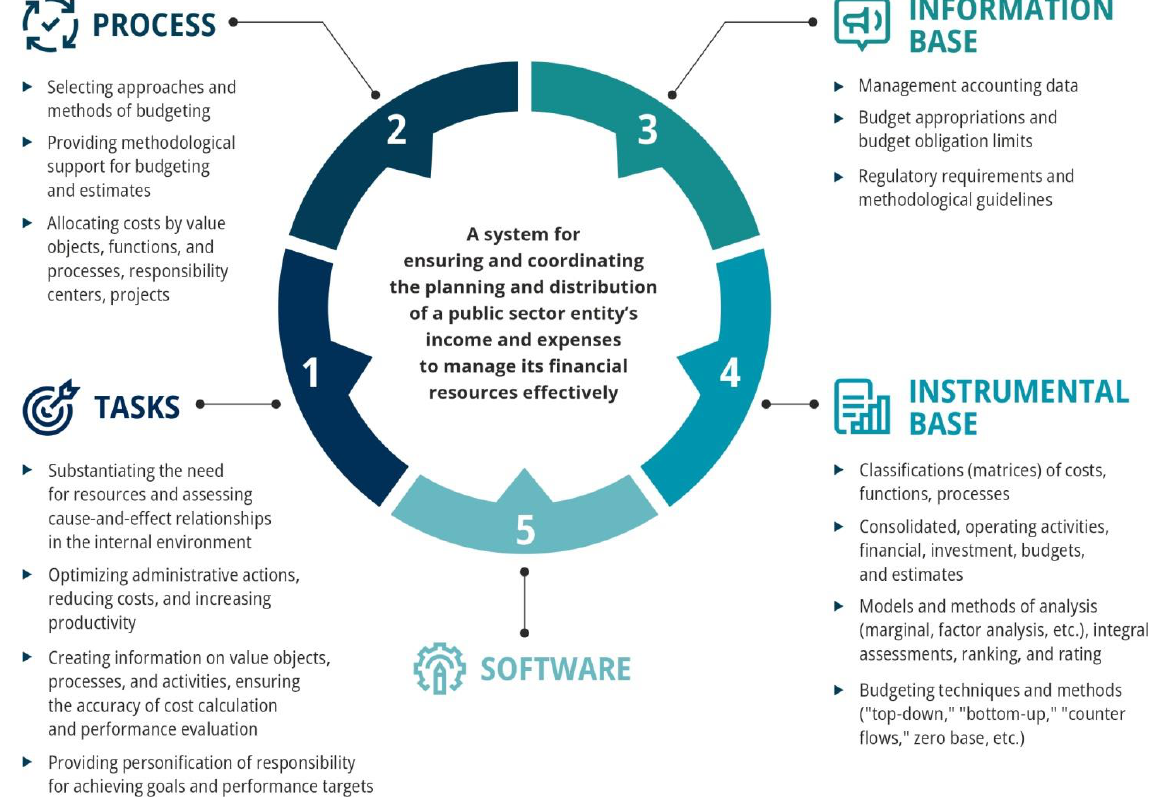
Figure 3. Controlling in the field of budgeting in state bodies and organizations (Compiled by the authors) Hypothesis 3 (H3): Controlling in the public sector increases public administration efficiency by improving control and diagnostic, organizational, and methodological tools and